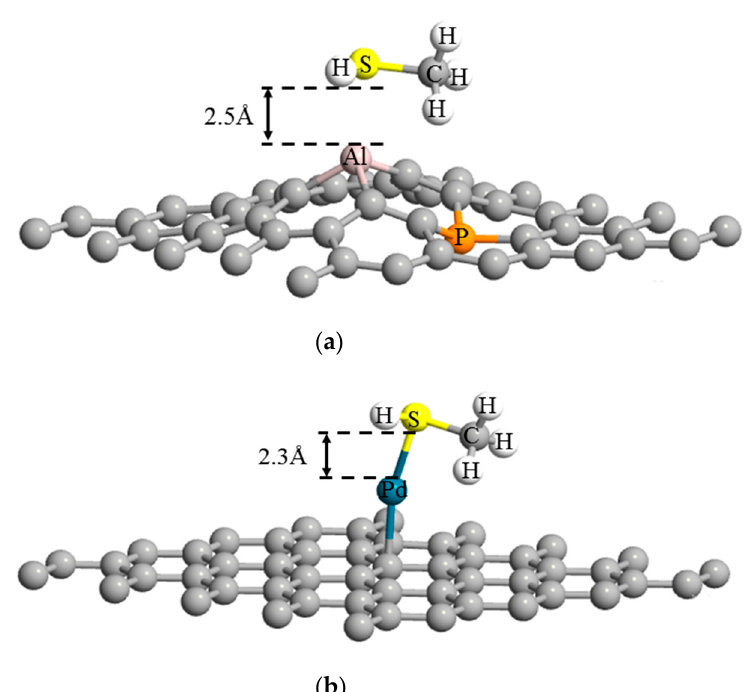
Figure 4. Optimized structures of graphene-biomolecule complex show ( a ) physiosorbed methanethiol biomolecule on Al-P-doped graphene lattice and ( b ) chemisorbed methanethiol biomolecule on Pd-decorated graphene lattice.